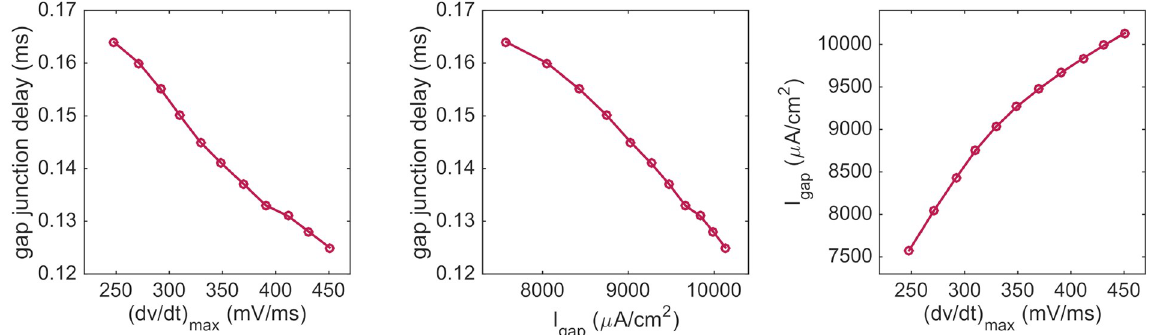
Fig 9. Relationship between the gap junction time delay, maximal upstroke velocity and gap junction current as the percentage of sodium channels moved to the cell ends is changed. The time delay is defined as the time between the membrane potential at the last computational node before the gap junctions between the sixth and seventh cells, and the first computational node after the gap junctions reach 0 mV. The upstroke velocity is computed at the first computational node after the gap junctions. The gap junction current density is computed between the sixth and seventh cell at the center of the domain in the y - and z -directions. The results are computed for the simulations displayed in Fig